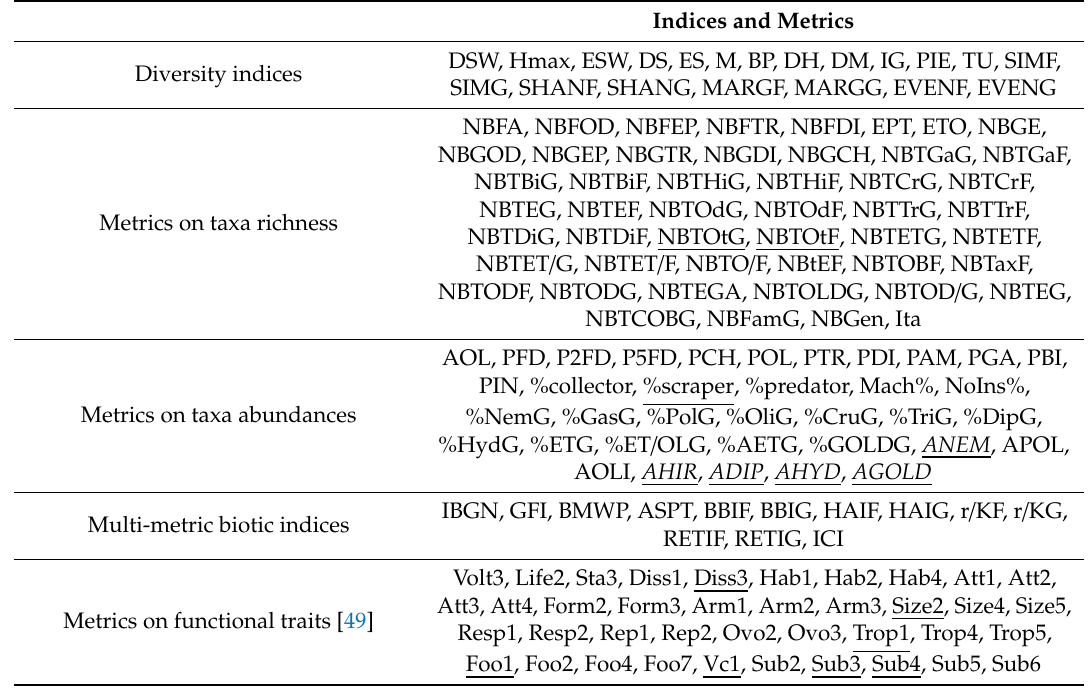
Table 2. List of the 157 metrics and indices retained after the first and second selection procedures. See Table S3 for full names and corresponding abbreviations. Taxa with significant di ff erence among habitat zones (normal font); taxa with significant di ff erence among sediment quality classes (italic font); taxa with significant di ff erences among both habitat zones and sediment quality classes (underline